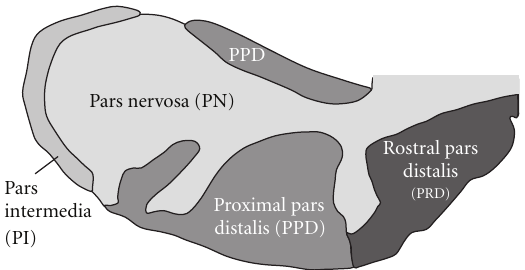
Figure 1: Sagittal view of zebrafish ( Danio rerio )